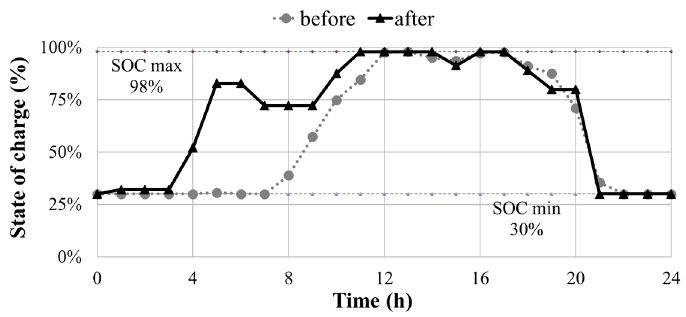
Figure 5. State of charge ( SOC ) before and after the prosumer problem solution.